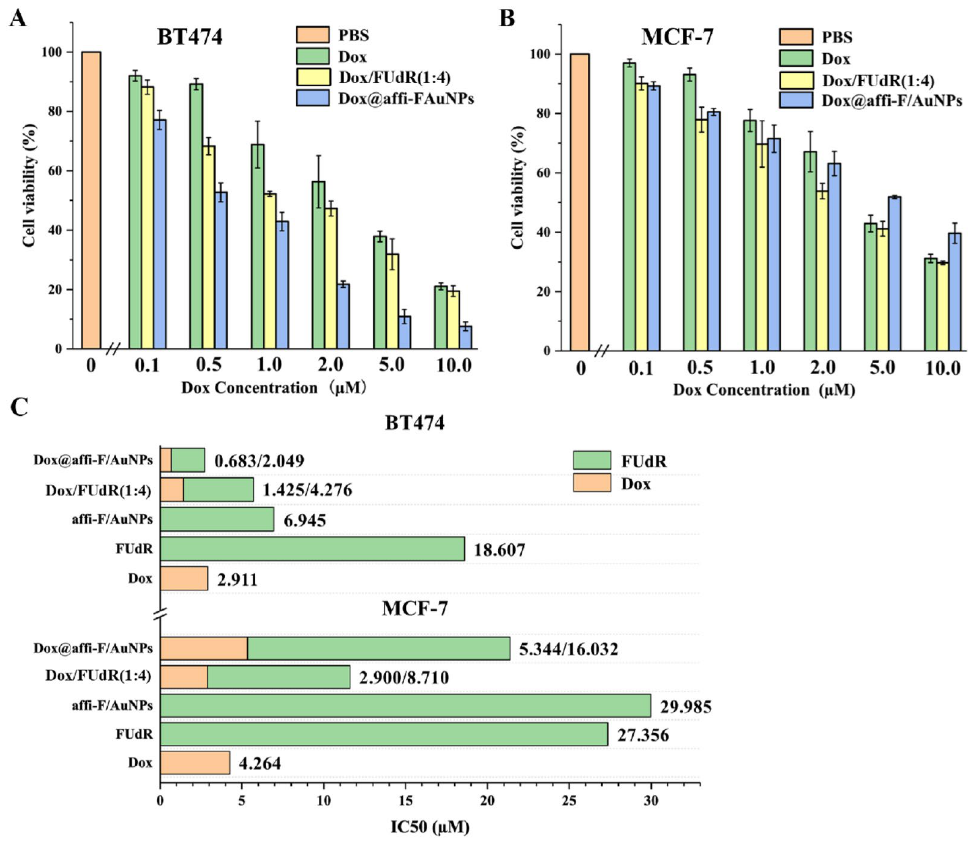
Figure 7. Cytotoxicity assay. Cell viability of BT474 ( A ) and MCF-7 ( B ) incubated with different concentrations of Dox, Dox/FUdR(1:4) and Dox@affi-DNA-AuNPs. ( C ) IC50 values of FUdR and Dox in BT474 and MCF-7 cells.